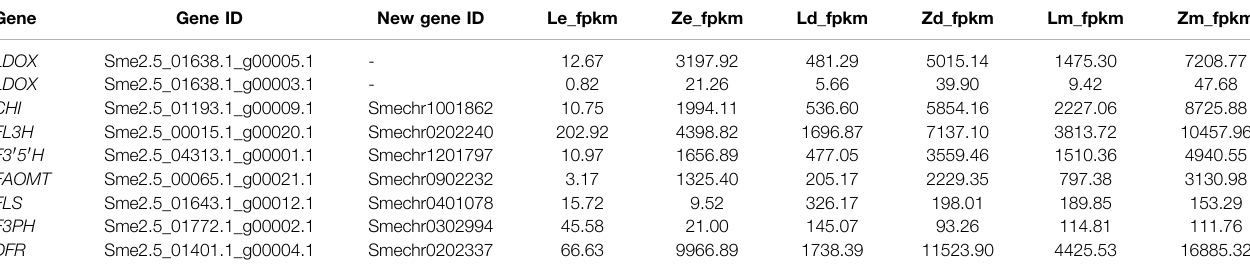
TABLE 1 | Expression analysis of genes related to fl avonoid biosynthesis. Gene